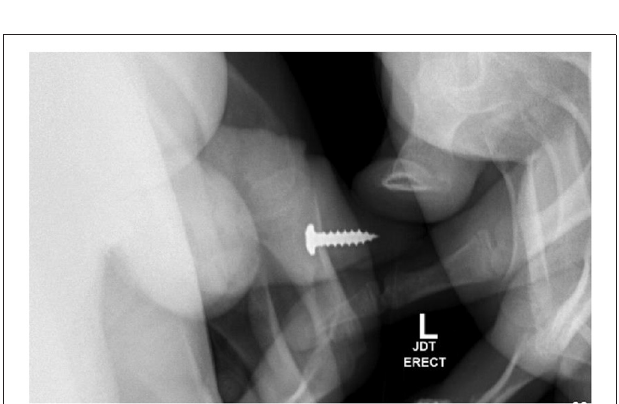
FIGURE 2 | Pelvic X-ray identifies metal screw in distal penile urethra, which was removed at bedside using a hemostat.